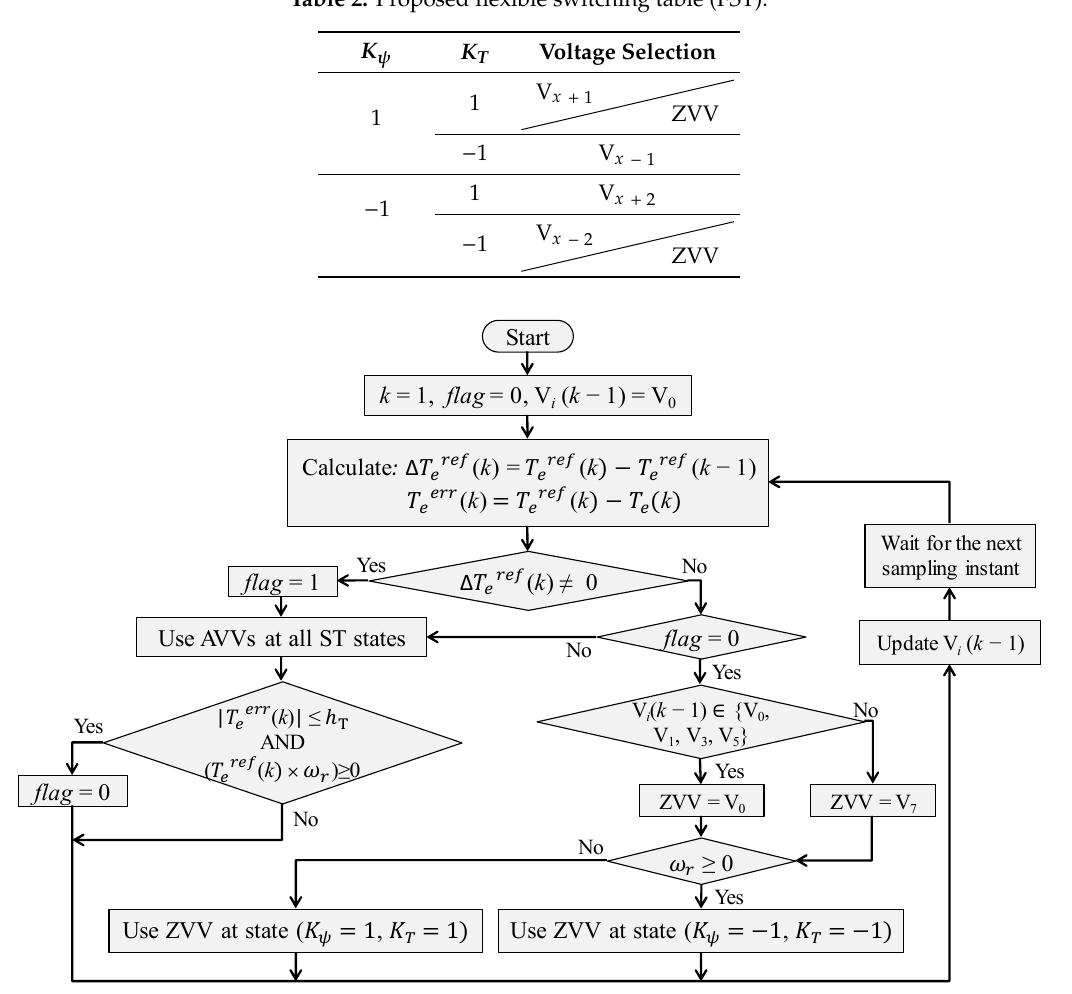
Table 2. Proposed flexible switching table (FST).